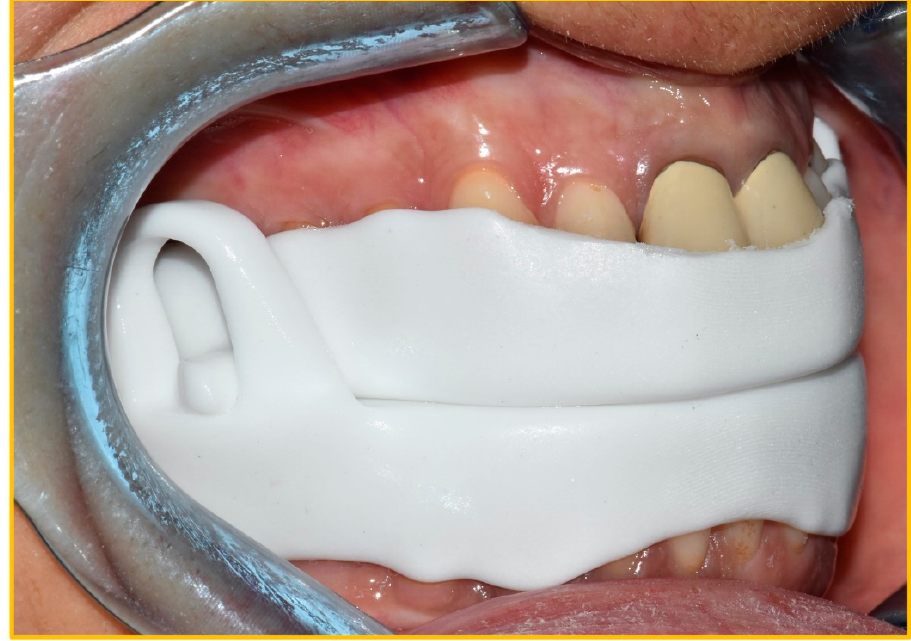
Figure 1. The device worn by the patient.